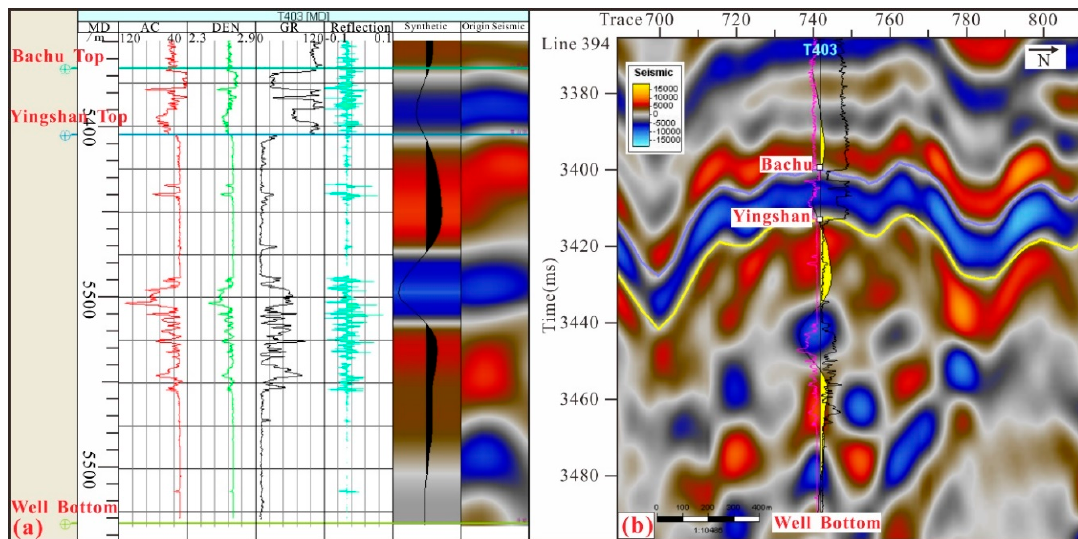
Figure 5. The synthetic seismogram at well T403, matching with the origin amplitude seismic image very well. ( a ) and ( b ) show that the synthetic geological record obtained by the reflection coefficient has the same peaks and troughs as the rightmost actual seismic trace.